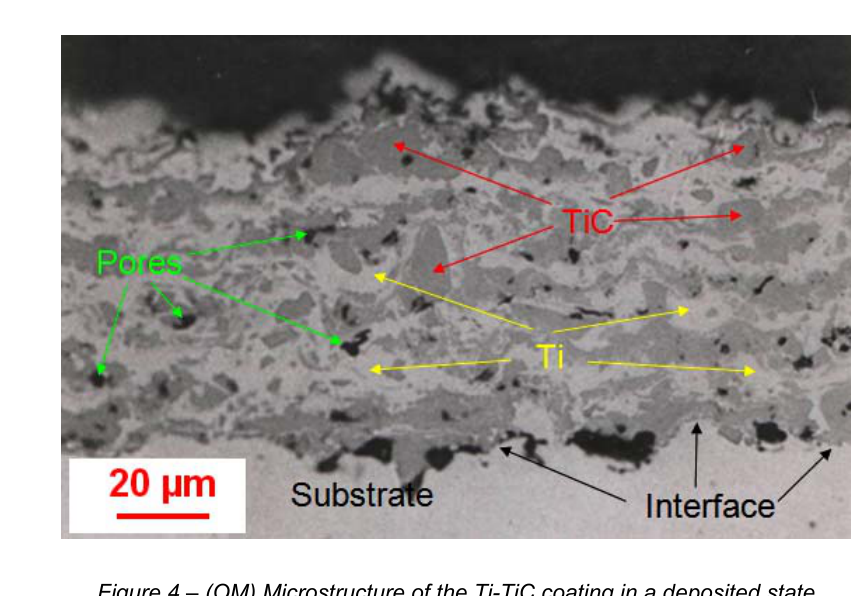
Figure 4 – (OM) Microstructure of the Ti-TiC coating in a deposited state Рис . 4 – (OM) Микроструктура нанесенного покрытия Ti-TiC Слика 4 – (OM) Микроструктура Ti-TiC превлака у депонованом